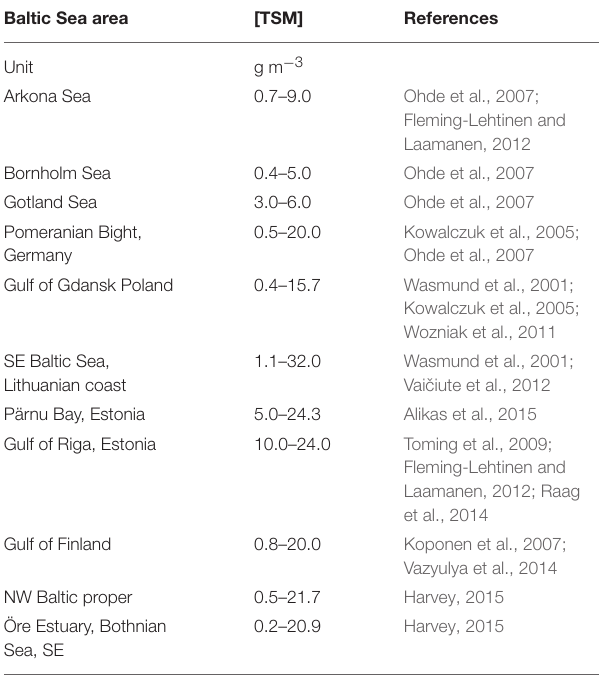
TABLE 1 | Comparison of the ranges of TSM concentrations [TSM] in different sub-basins of the Baltic Sea. Baltic Sea